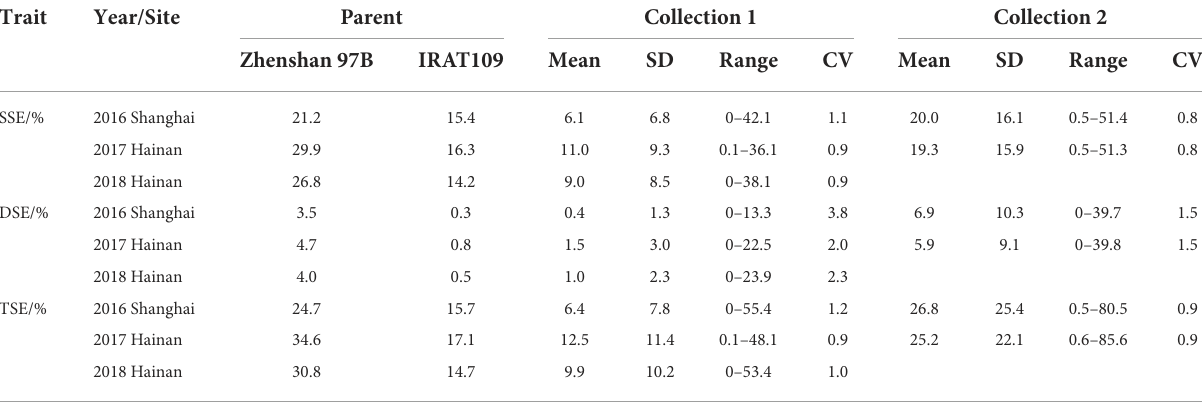
TABLE 1 Phenotypic information regarding the stigma exsertion rate of the parents and two collections across 3 years. Trait